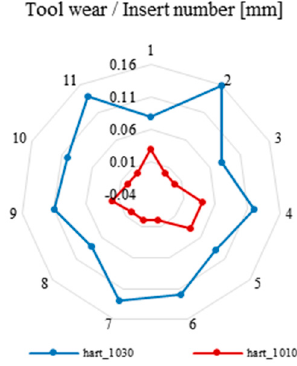
Figure 14. Comparison of tool wear after hard machining of 32.784 m with inserts of type 1030 and 1010.